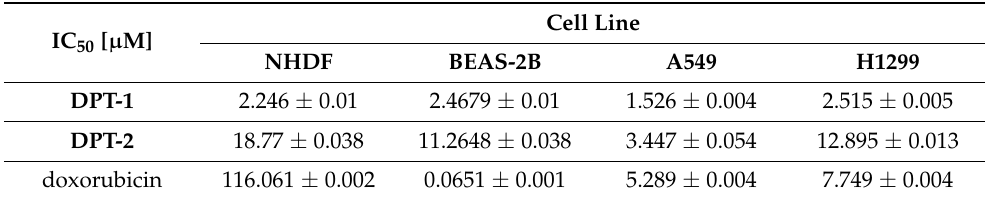
Table 1. IC 50 value after 72 h of incubation with tested phenothiazines and doxorubicin for tissue- dependent effects in NHDF, A549, and H1299 cell lines.